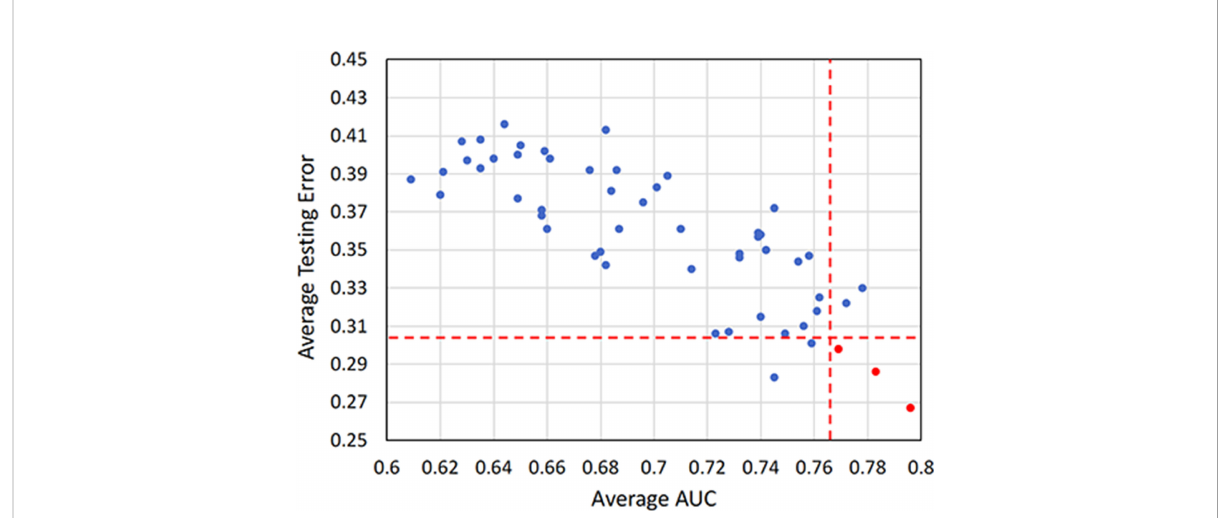
FIGURE 5 A scatterplot depicting the mean internal validation AUC and testing error of all 54 cross-combinations derived from six feature selection methods and nine classi fi cation methods. Two red dotted lines distinguish the combinations that show top fi ve performance in AUC and testing error. Three highly reliable and prognostic combinations that show top fi ve performance in both AUC and testing error (RF + RF, RF + AdaBoost, and L 1 -LOG + KSVM) are displayed in red points. AUC, area under the receiver operating characteristic curve; RF, Random Forest; AdaBoost, Adaptive Boosting; L 1 -LOG, L1-Logistic Regression; KSVM, Kernel Support Vector